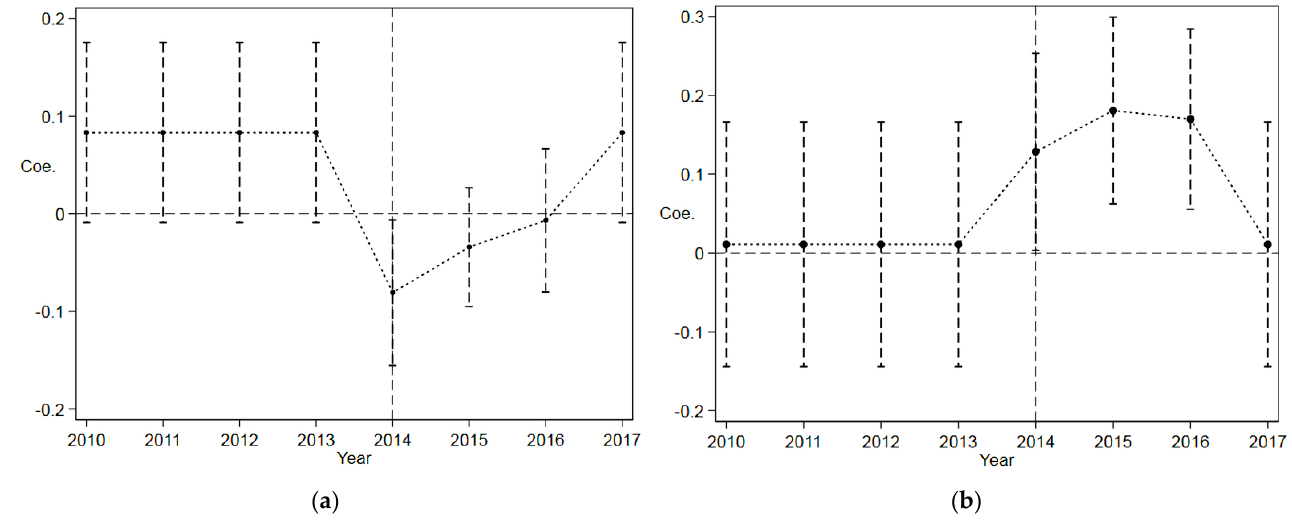
Figure 7. Parallel trend test. ( a ) Explained variable is LUE_Eco. ( b ) Explained variable is LUE_Env.